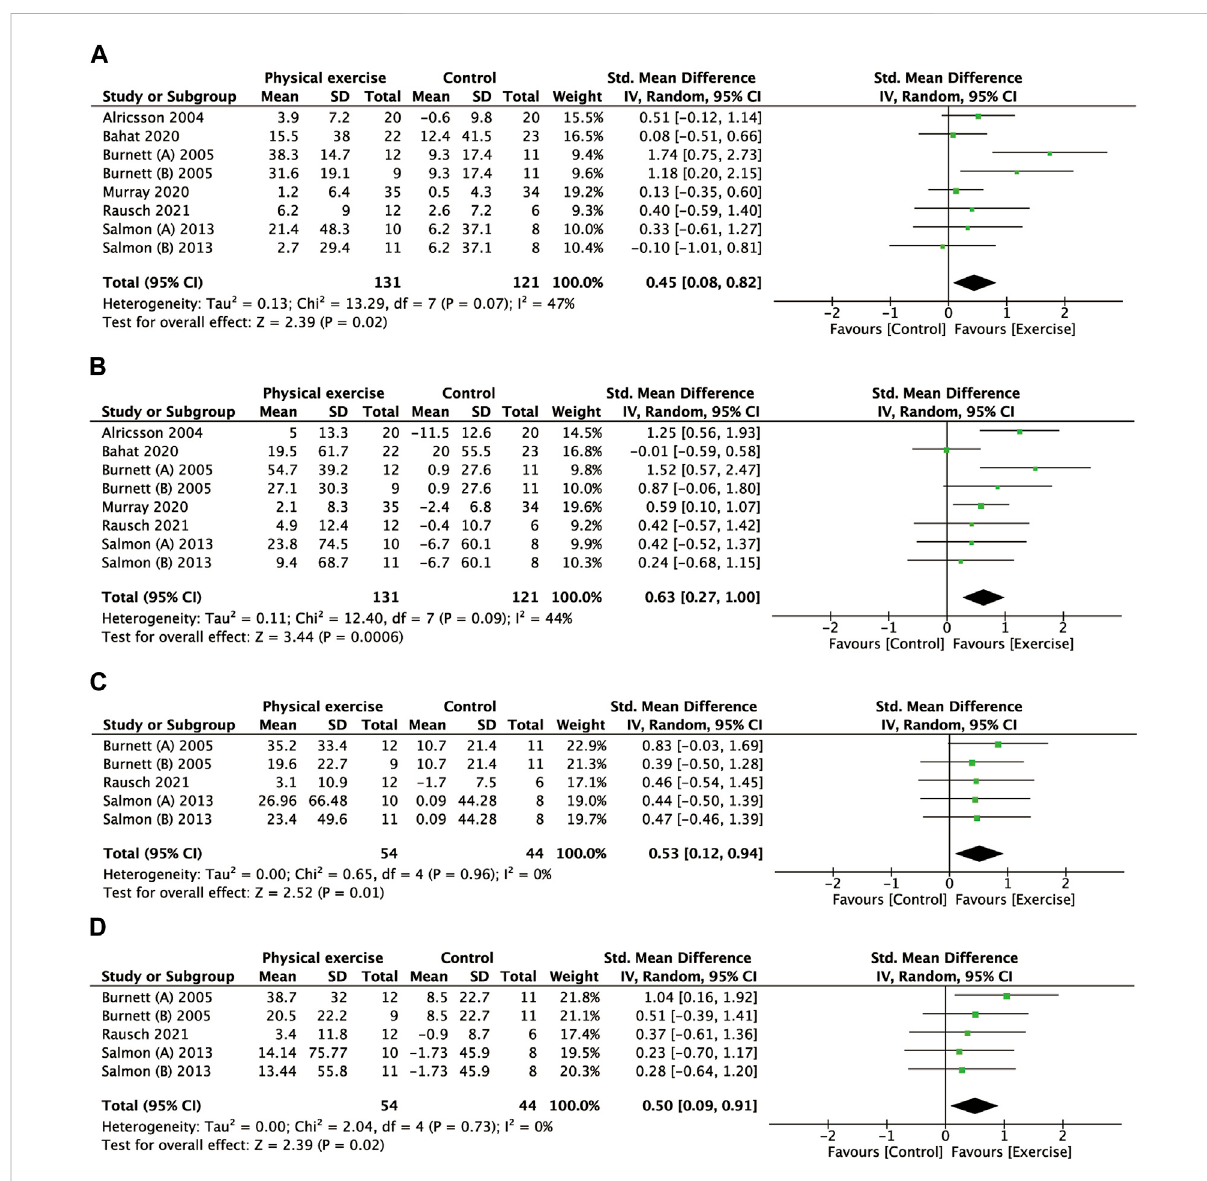
FIGURE 2 Forest plot comparing the MVIC of the neck in the physical exercise and control groups. (A) Flexion. (B) Extension. (C) Right lateral fl exion. (D) Left lateral fl exion. MVIC, maximal voluntary isometric